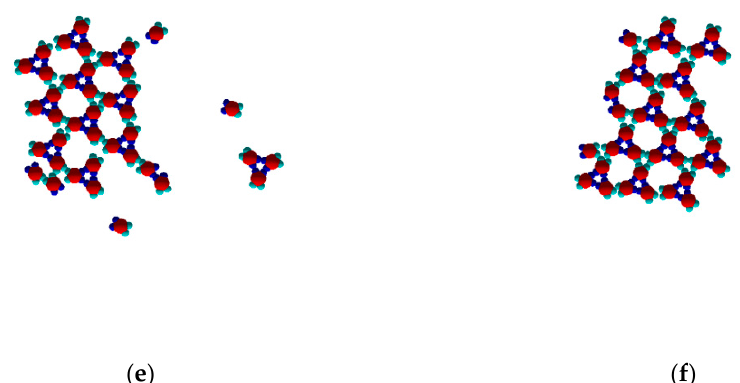
Figure 8. Sequence of images ( a–f ) revealing the details and different stages of transformation from Rh to TriHex 2D clusters at T* = 0.1 ( a : 1 × 10 3 MCS; b : 2 × 10 3 MCS; c : 5 × 10 3 MCS; d : 1 × 10 4 MCS; e : 1 × 10 5 MCS; f : 5 × 10 5 MCS).